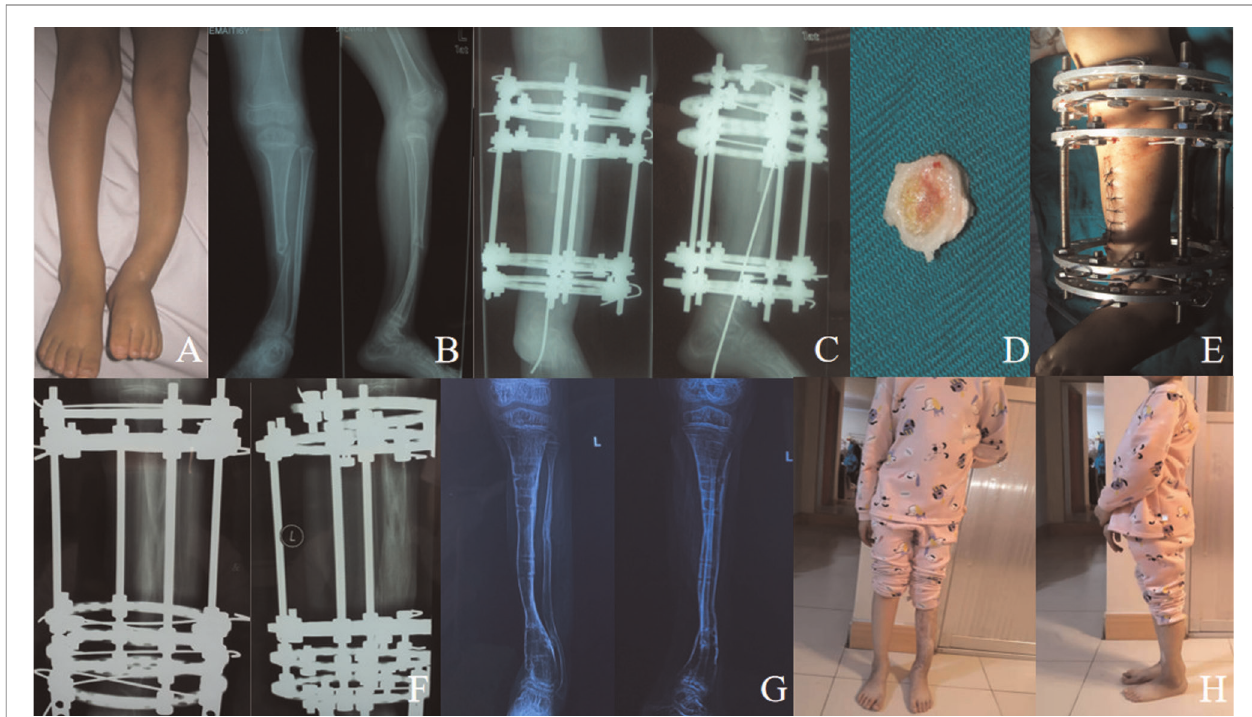
FIGURE 1 | Case of a 6-year-old girl with CPT Crowford type IV associated with NF1. ( A ) Preoperative photograph showing congenital tibial pseudoarthrosis on the left side and leg length discrepancy (LLD). ( B ) Anteroposterior and lateral X-rays showing Crawford type IV CPT. ( C ) Anteroposterior and lateral radiographs viewed 2 days after resection of the pseudoarthrosis and then a Ilizarov fi xator combined with intramedullary fi xation of the tibia was carried out to manage the pseudarthrosis. ( D ) Excised fi brous tissue and bone of CPT. ( E ) Postoperative photos after Ilizarov fi xator installation. ( F ) Anteroposterior and lateral X-ray fi lms at 105 days after operation when docking site was reached; the intramedullary K-wire was removed because of the obvious pin-tract infection in the plantar soft tissue. ( G ) Anteroposterior and lateral radiographs taken at age 9 years showing a well-aligned tibia and bone union. ( H ) Function recovery at 41 months after removal of the external fi